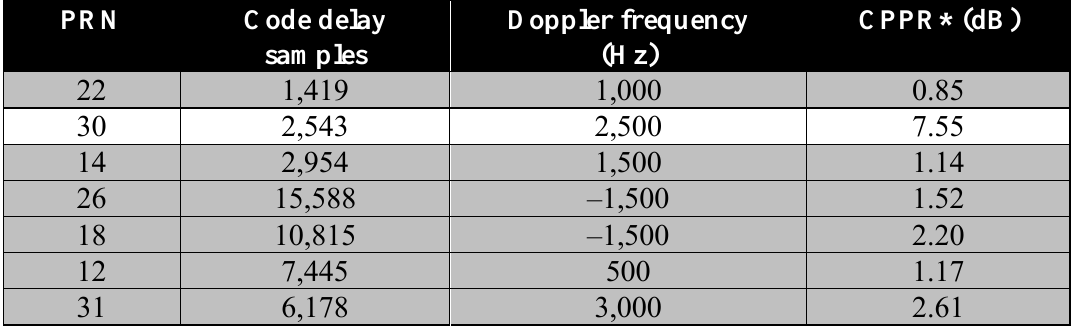
Table 2. The acquisition result of the collected indoor signal by the conventional acquisition method with the integration time of 1 millisecond.